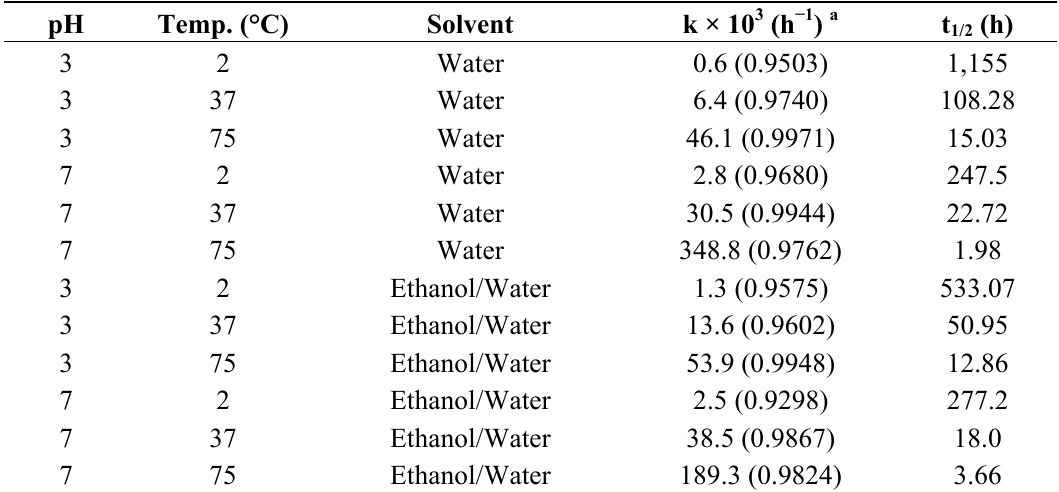
Table 1. Kinetic parameters of degradation of anthocyanins from Cranberrybush fruits extracts in different